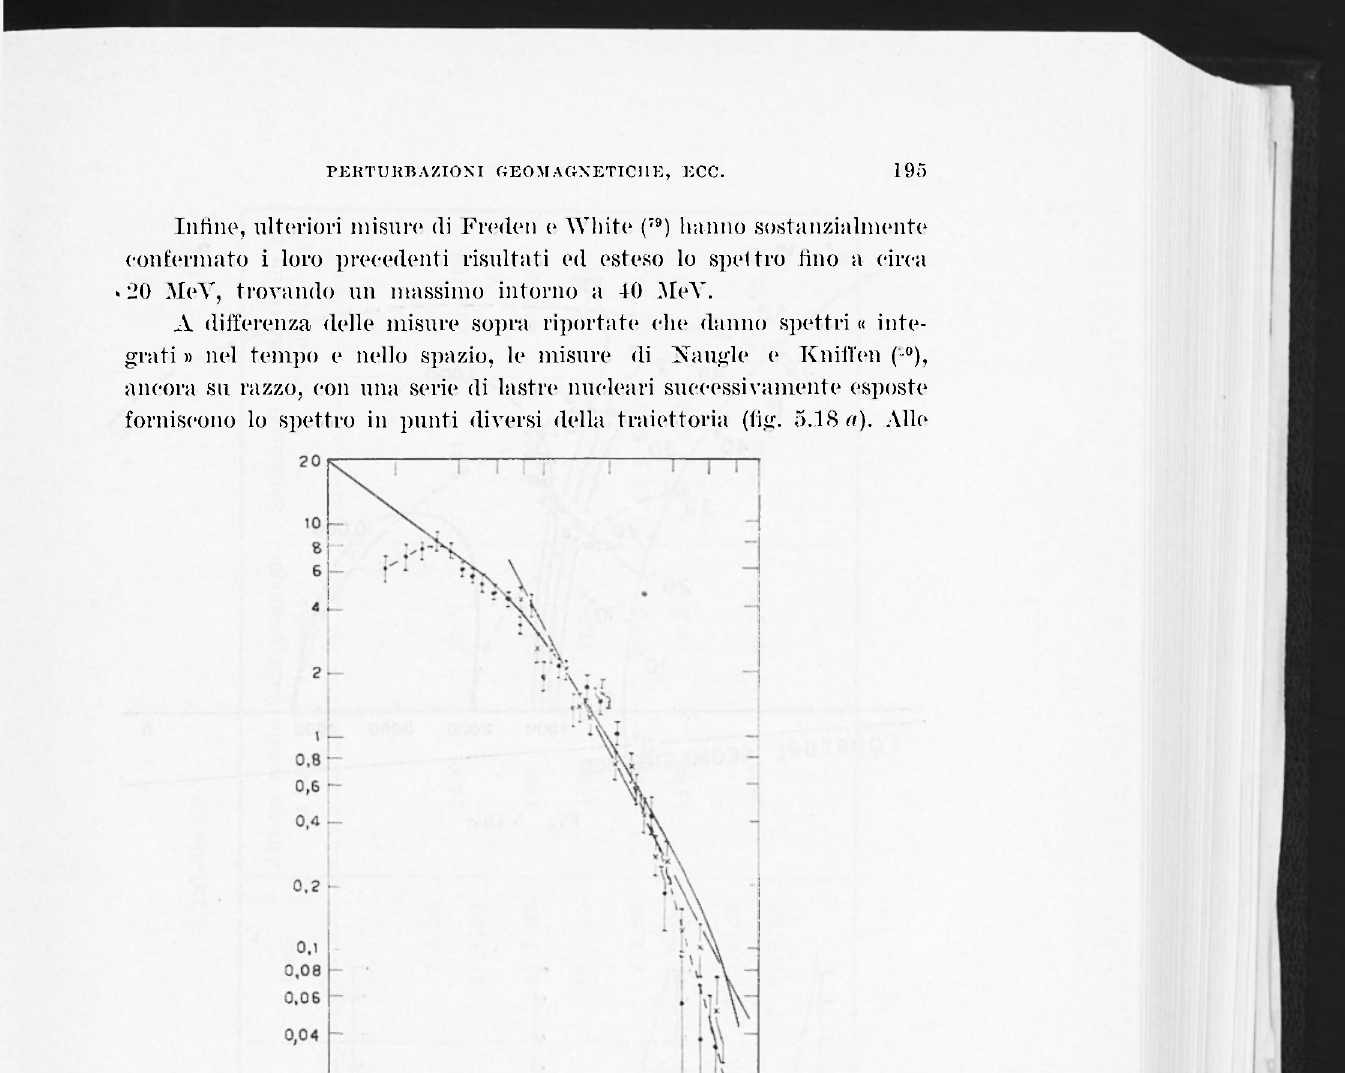
Fig. 5.17 - Spettro energetico differenziale dei protoni, in protoni - MeV